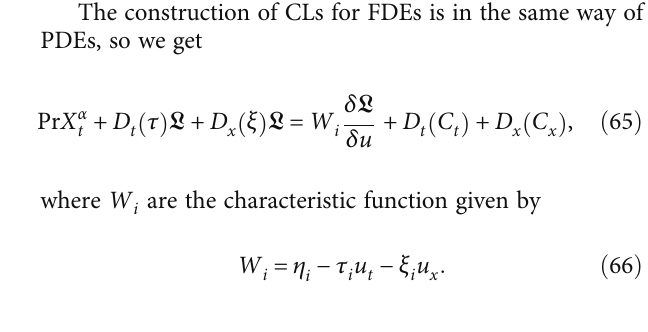
Figure 4: The solution u